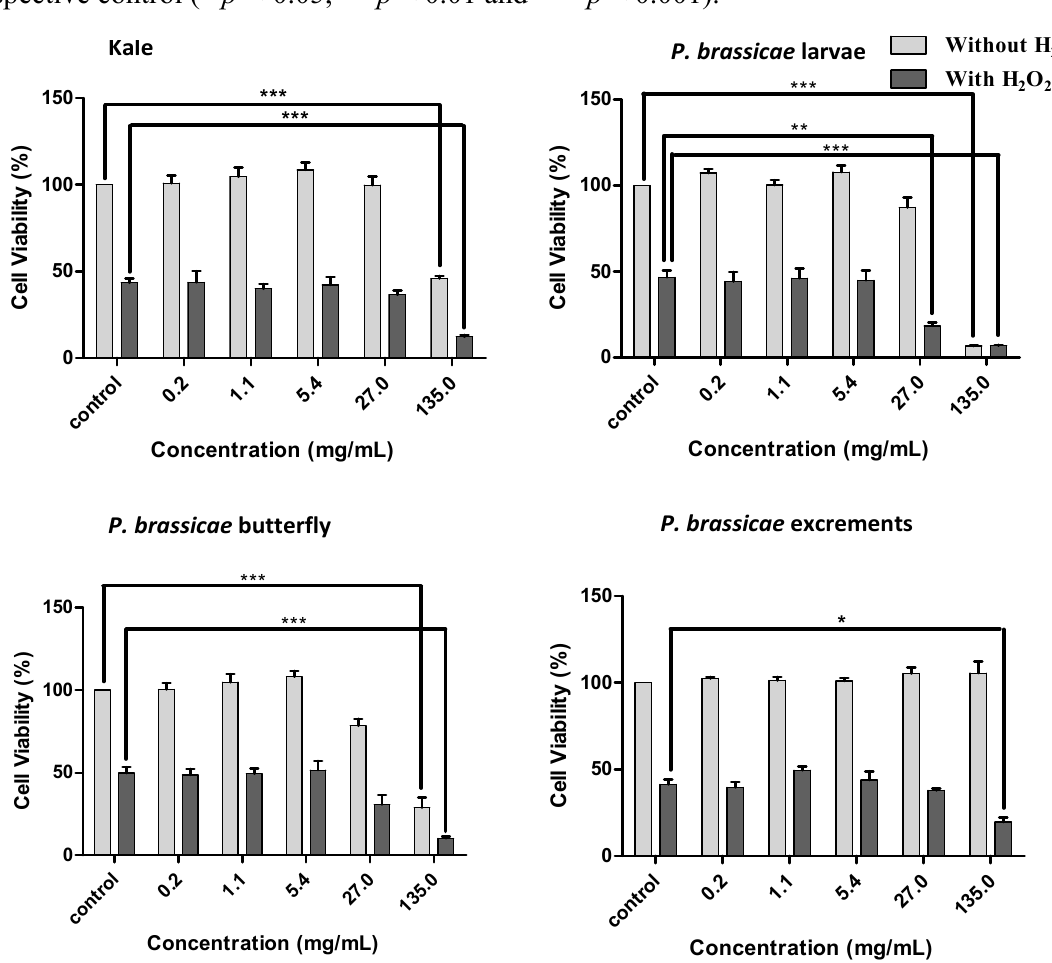
Figure 5. Effect of B. oleracea var. acephala and P. brassicae materials methanolic extracts on V79 cells viability with and without H show mean ± SE (n = 4). Mean values were significantly different compared with the respective control ( * p < 0.05, ** p < 0.01 and *** p < 0.001).